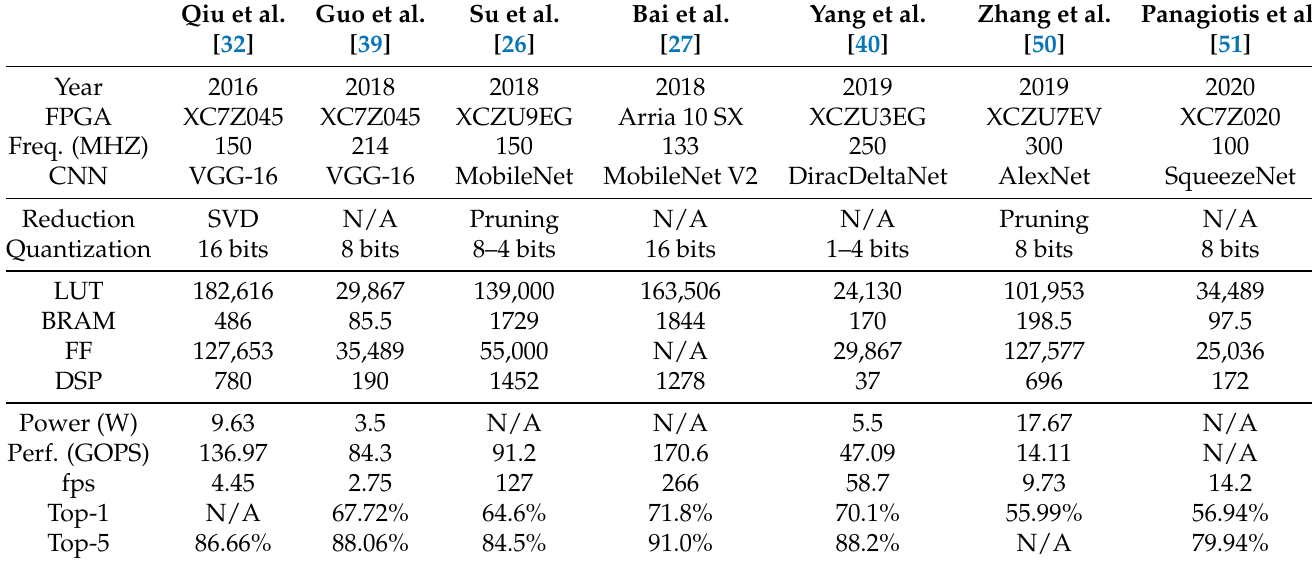
Table 1. FPGA-based CNN inference described in the literature (N/A: Not available). Qiu et al. Guo et